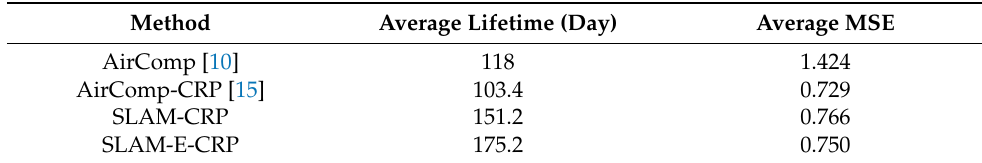
Table 2. Average lifetime and MSE of four methods ( K = 40, 𝛼 = 0.5).